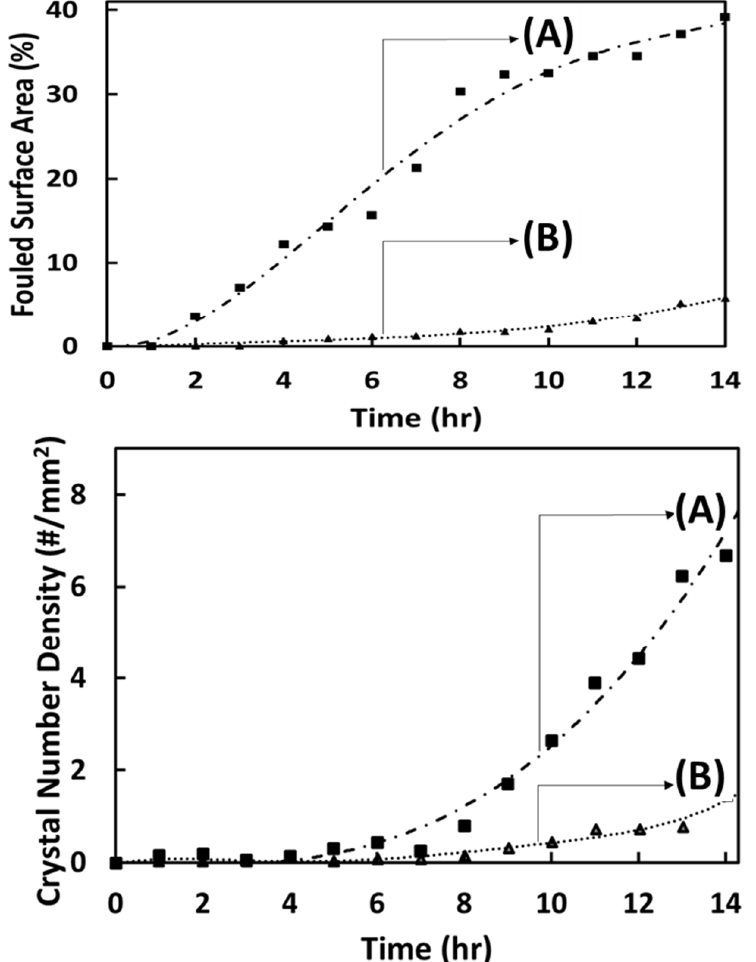
Figure 7. Comparison of surface coverage and crystal number density analyzed from real-time membrane images during prefiltration testing indicating a comparison of observed mineral scaling configurations A and B. PFRO operating conditions: crossflow velocity = 4.5 cm/s, initial permeate flux = 33 L/m 2 -h (19 gallons/ft 2 -day), and SI g,m = 1.9–2.0 corresponding to equivalent RO plant recovery of 63%. RO feed pretreatment with media filtration and hydrocyclone and without UF and with UF pretreatment identified as configurations A and B, respectively (Figure 2).